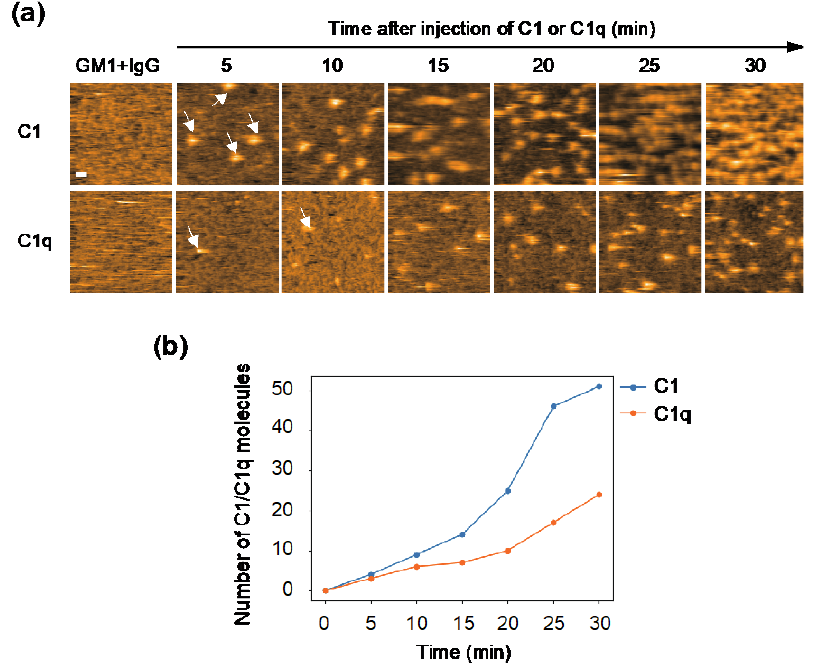
Figure 2. HS-AFM observation of C1/C1q interaction with IgG assemblages on antigen-incorporated membranes. ( a ) HS-AFM images every 5 minutes, showing the interaction of C1/C1q with the anti-GM1 antibody assembling on DOPC membranes containing 50% GM1. Typical images showing C1/C1q bound to the IgG assemblages (indicated by the white arrows). Scale bar = 20 nm. ( b ) The amount of C1/C1q residing on the IgG assemblages formed on the GM1-incorporated membrane, increasing depending on time, was quantified.